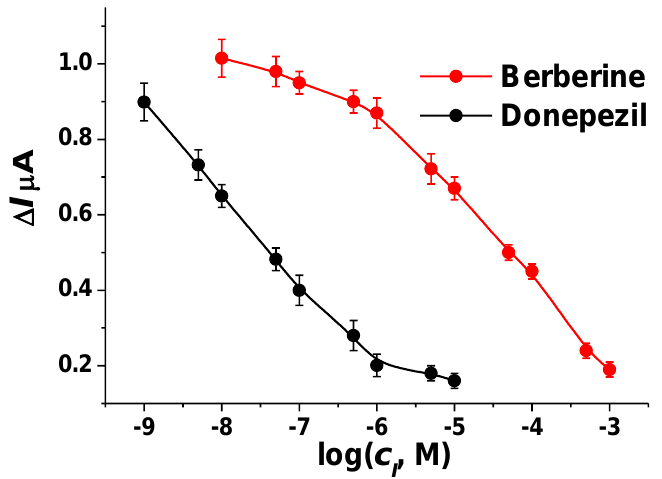
Figure 8. Calibration curves of donepezil and berberine were obtained with the flow-through AChE biosensor. AChE 5 U per biosensor, ATCh 1.0 mM, flow rate 0.2 mL/min, phosphate buffer, pH = 7.0. Average ± standard deviation for six measurements.